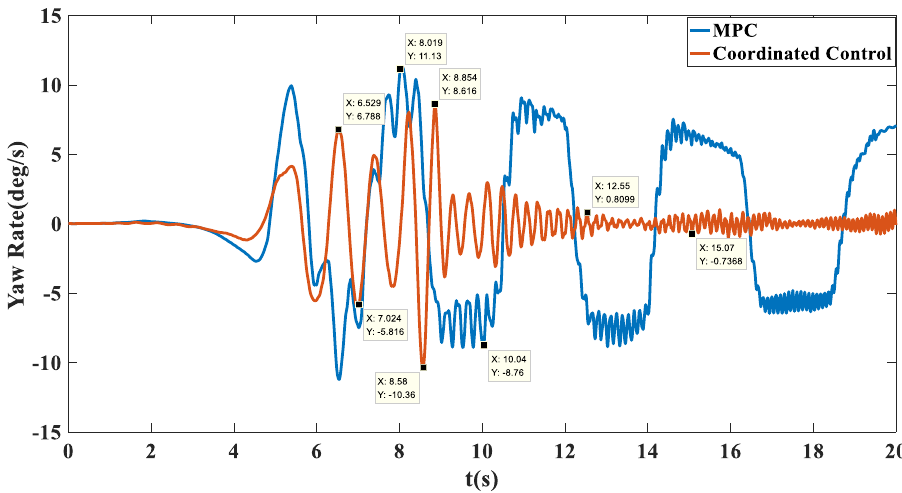
Figure 20. Transverse pendulum angular velocity tracking comparison chart on the Sine sweep straight